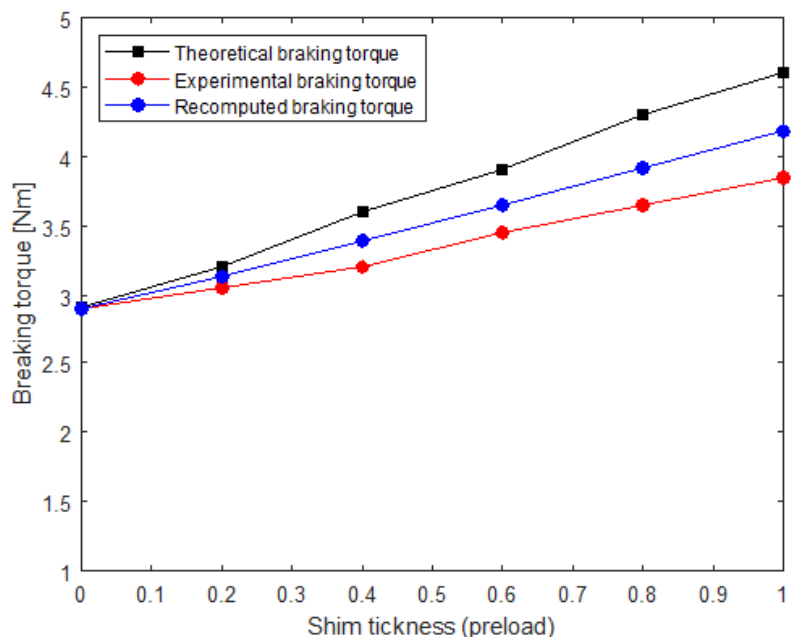
Figure 12. Comparison between theoretical, experimental, and recomputed braking torque.